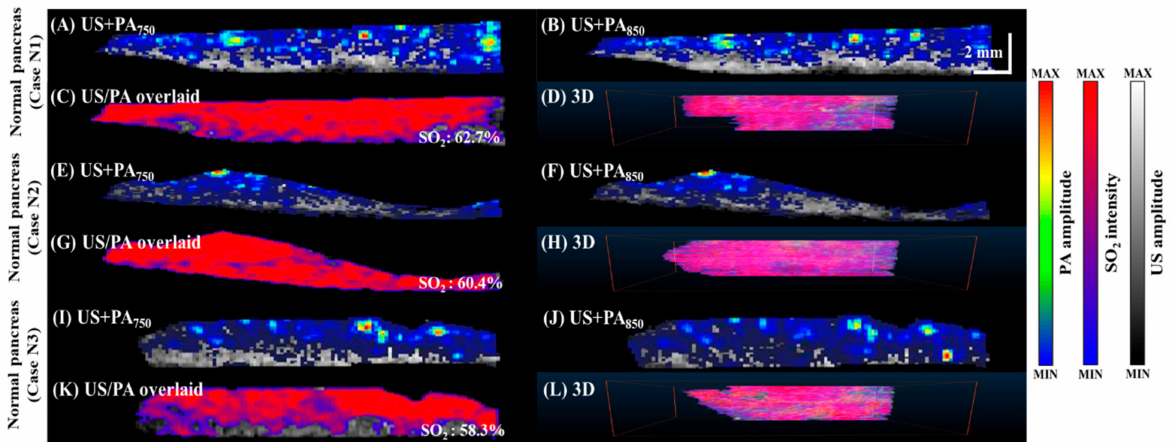
Figure 5. Relative SO 2 levels in normal pancreatic regions in three different mice. SO 2 was calculated as the percentage of oxygenated hemoglobin relative to total hemoglobin based on dual-wavelength PA imaging at 750 and 850 nm. ( A , E , I ) PA images acquired at 750 nm overlaid with grayscale US B-mode images. ( B , F , J ) PA images acquired at 850 nm overlaid with grayscale US B-mode images. ( C , G , K ) Calculated SO 2 dynamics overlaid with grayscale US B-mode images. ( D , H , L ) C-scan image of SO 2 dynamics overlaid with US. Rotational 3D images can be seen in Supplementary Materials Video S1.